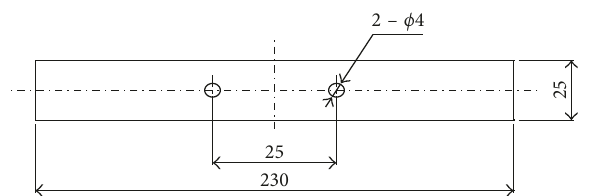
Figure 3: The fatigue S-N specimen of the laminate material (unit: